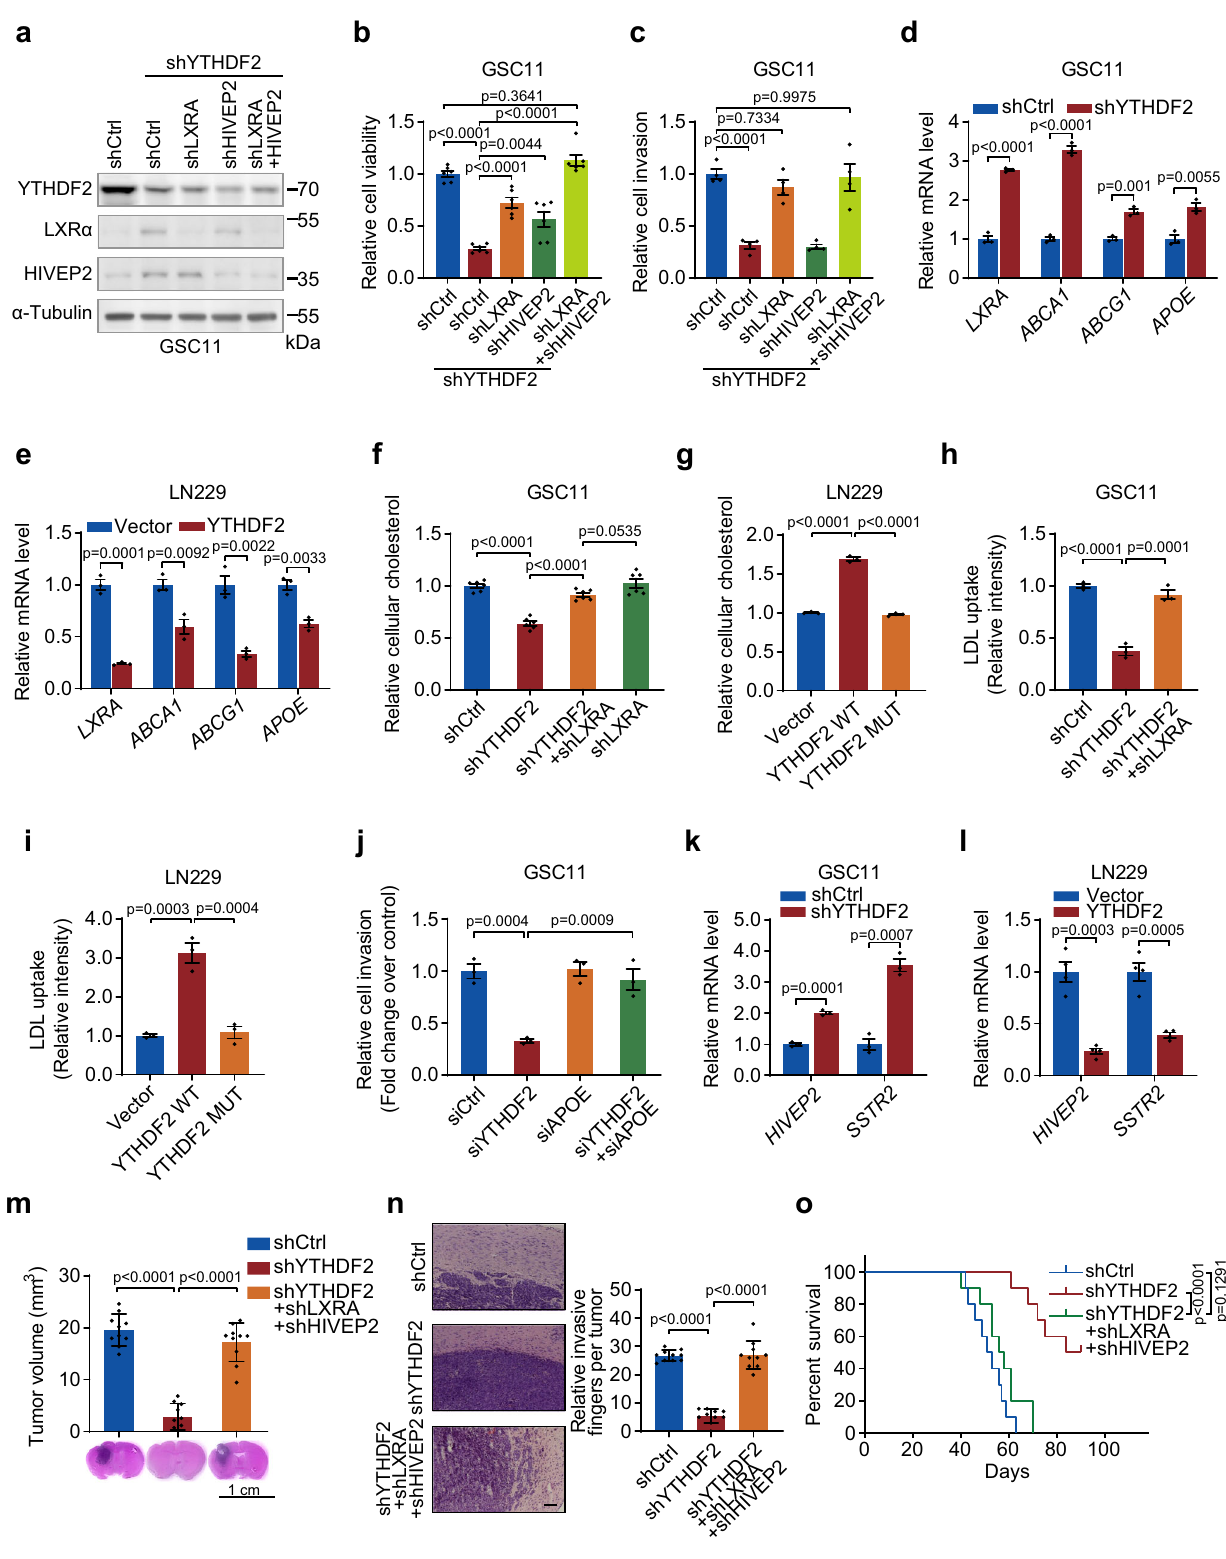
Cellular cholesterol determination . Cellular cholesterol levels were measured with the Amplex ® Red Cholesterol Assay Kit (Invitrogen), a fl uorometric technique in which cholesterol is oxidized into a ketone and hydrogen peroxide, which then reacts stoichiometrically with the Amplex Red reagent (10-acetyl-3,7-dihydrox- yphenoxazine) in the presence of horseradish peroxidase to form the fl uorescent compound resoru fi n. To perform this assay, 5× 10 5 indicated cells were plated in wells of 24-well; viable cell fractions were determined by Vi-CELL XR cell counter